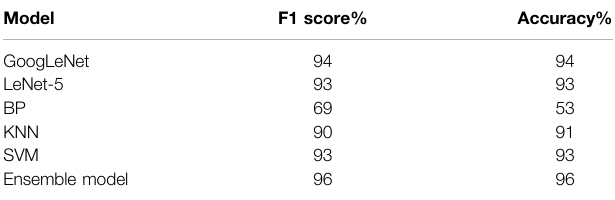
TABLE 4 | Ensemble model training